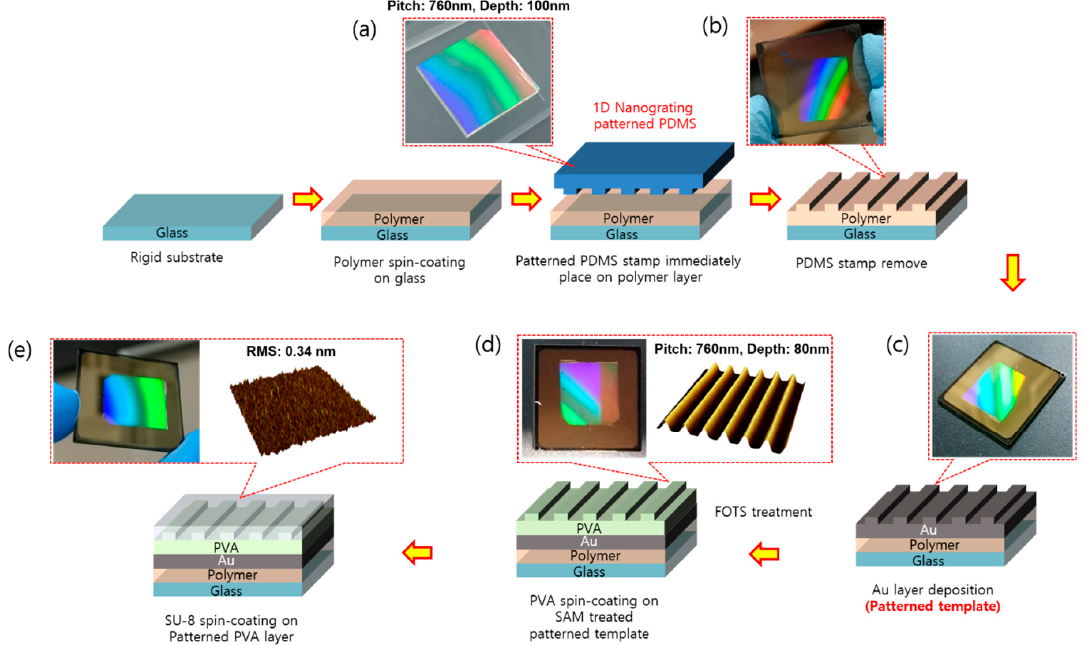
Figure 1. Schematic illustration of the fabrication process of one-dimensional (1D) nanograting patterned polymer substrate by soft nano-imprinting lithography using a PDMS mold. Photographs of ( a ) the PDMS mold, ( b ) the patterned polymer layer, ( c) the Au deposited patterned polymer layer, ( d ) the poly (vinyl alcohol) (PVA)-coated patterned template (left) and the three-dimensional (3D) surface image of PVA by atomic force microscopy (AFM), and ( e ) the epoxy (SU-8) coating on the PVA-coated patterned template ( left ) and the 3D surface image of SU-8 by AFM ( right ) are shown in the insets.